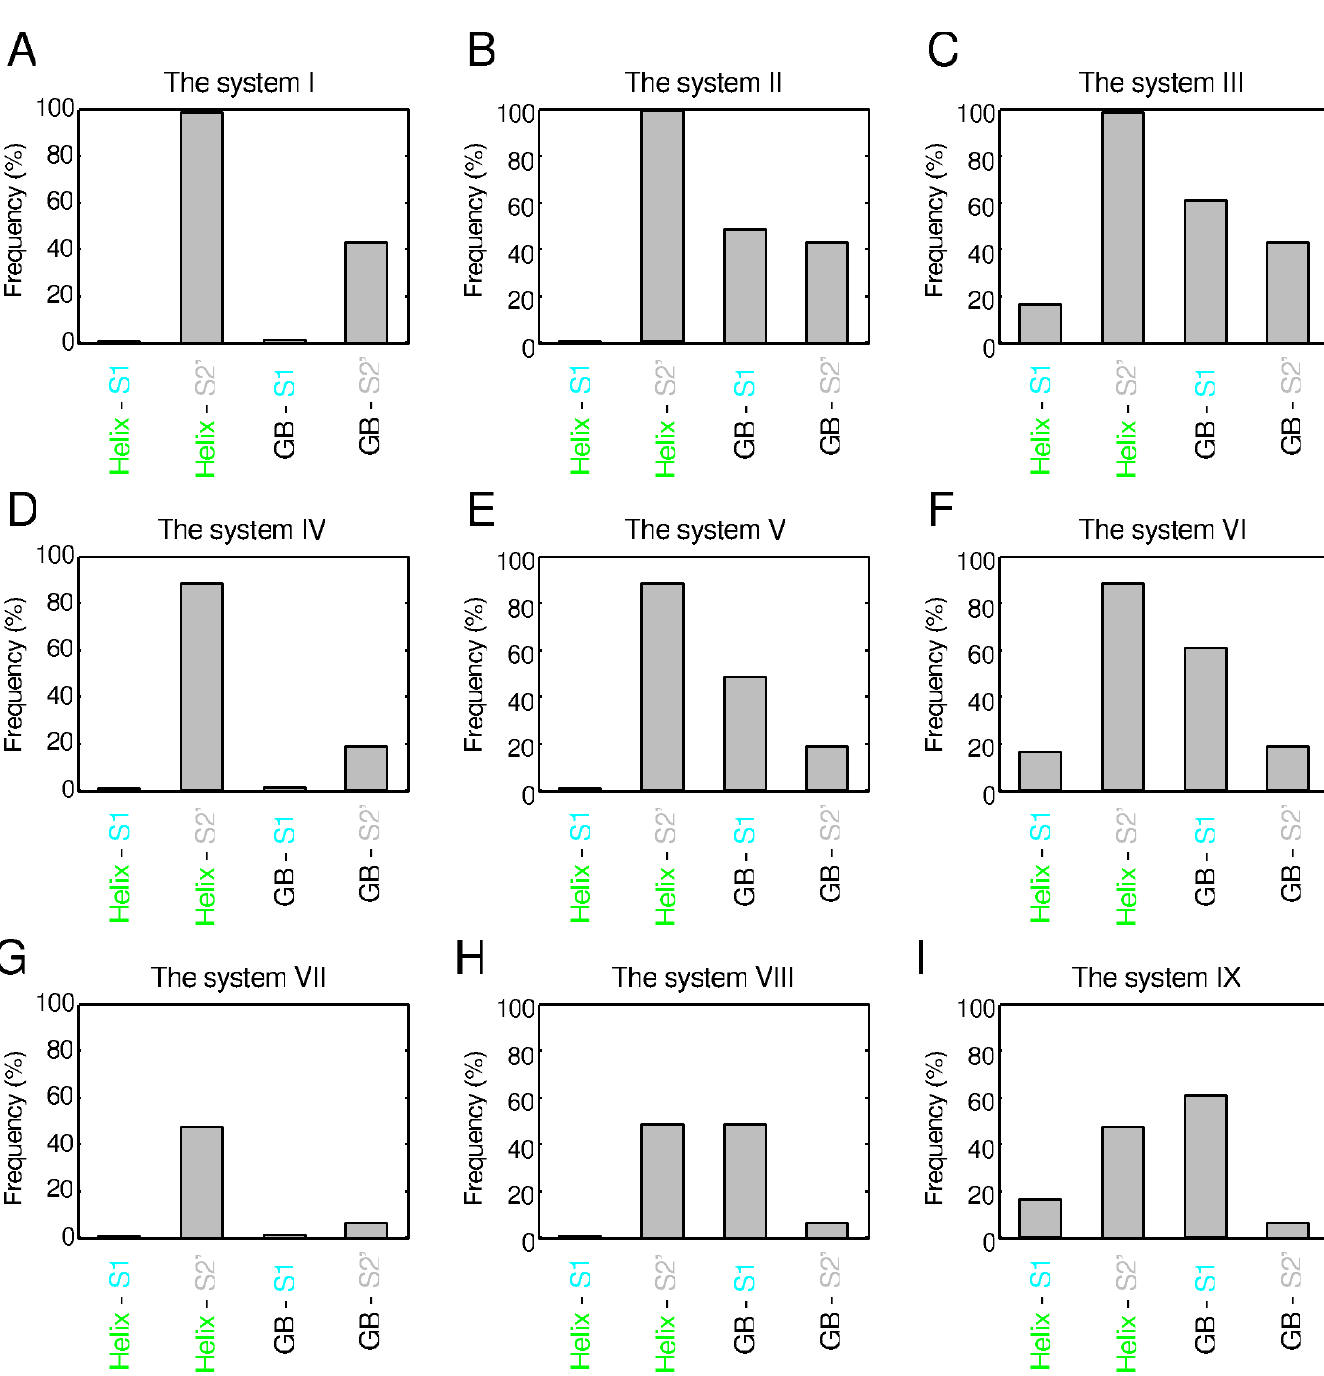
Fig 7. Frequency of structures with inter-atomic collisions between a given secondary structure pair for each of the system (from I to IX). The collision probability between the α -helix and S2 is not shown, because structures with such inter-atomic collisions were precluded before the implantation of the αβ -unit into the three- stranded β